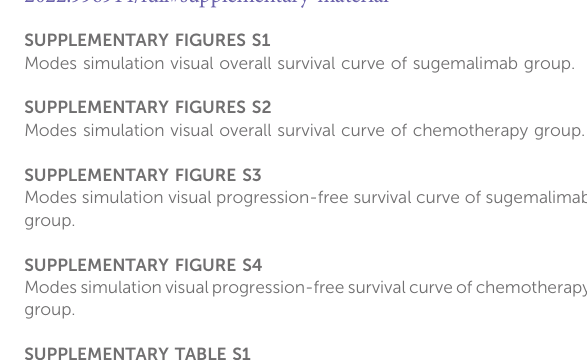
SUPPLEMENTARY TABLE S1 Comparison of survival